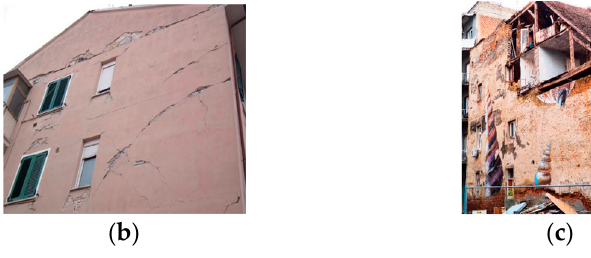
Figure 1. Recent OOP collapse mechanisms in masonry structures (a) flexure damage [7] , (b) and (c) OOP rocking damage of unsupported walls [8,9].